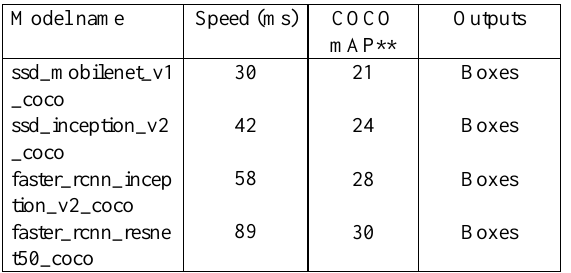
Table 1. Metadata of selected object detection model in